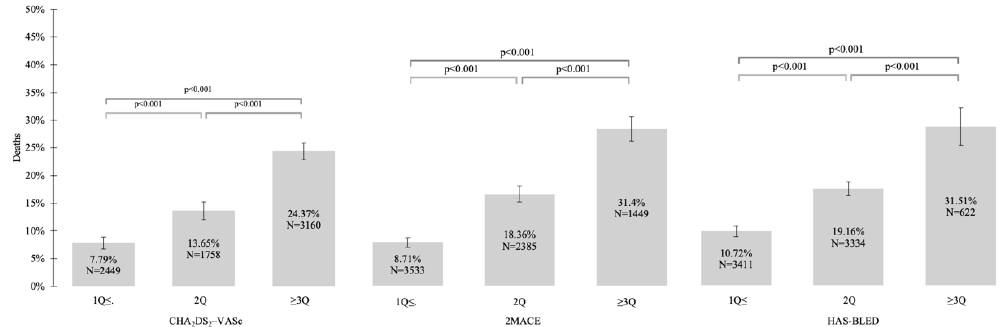
Figure 1. Relationship between all-cause mortality and CHA 2 DS 2 -VASc, 2MACE, and HAS–BLED scores in the overall study population. Abbreviations: Q, quartile.